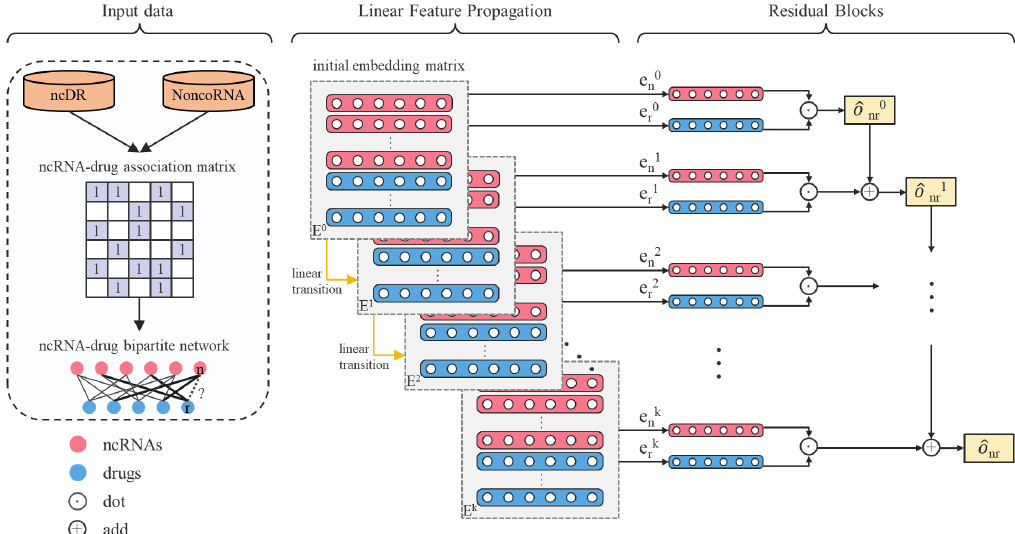
Figure 1. Flow chart of LRGCPND. E 0 denotes the embedding matrix in layer 0. e 0 n and e 0 r denote the embedding of ncRNA n and drug d in layer 0, respectively. LRGCPND contains three steps: aggregation, linear transition, and residual learning. In the feature aggregation step, we use the spectral rule to aggregate the features of neighboring nodes. After that, the linear transformation is adopted to speed up the forward propagation. Finally, we add a residual block to fuse the characteristics of low-layer nodes directly, attaining higher-layer potential features.